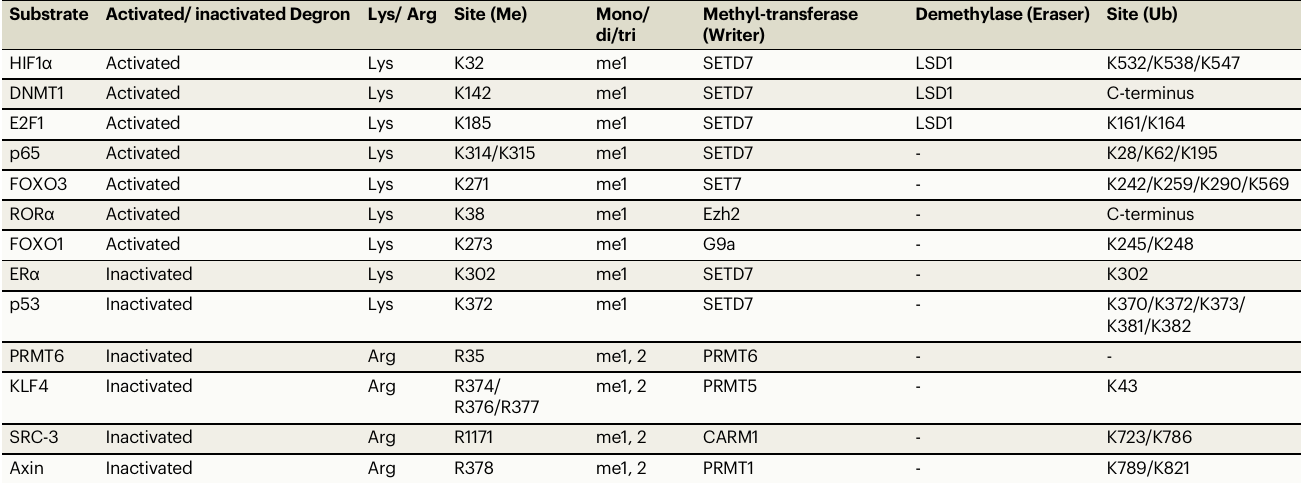
Table 1 | List of methyl-activated and -inactivated degron with corresponding writer and eraser Substrate Activated/inactivatedDegron Lys/ Arg Site